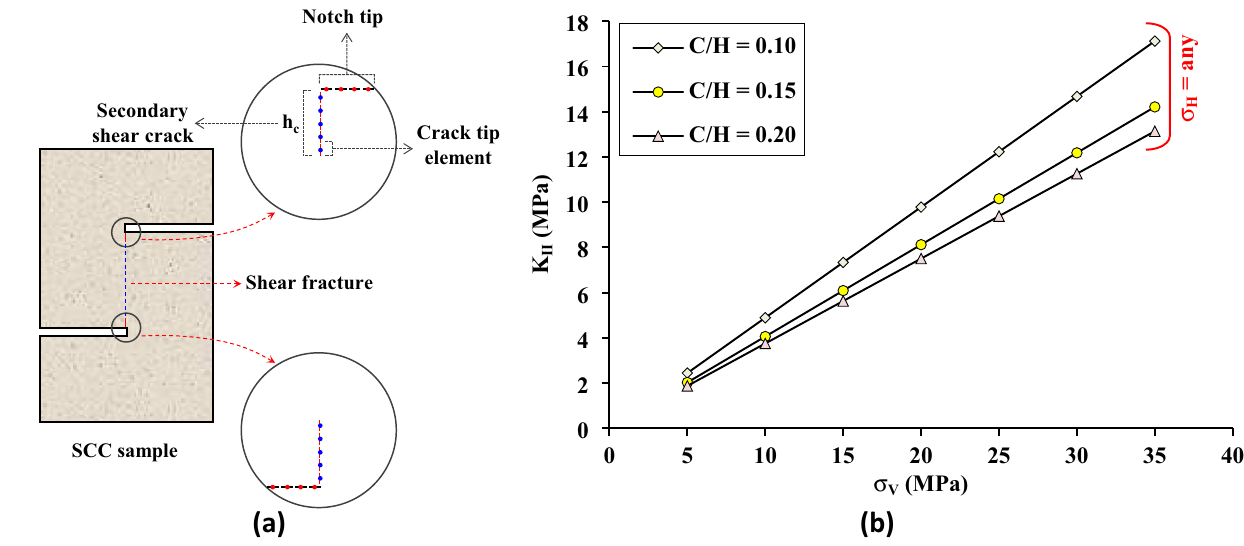
Figure 3. Stress intensity factor in SCC specimens, ( a ) modeling of the secondary shear crack in SCC specimen using DDM, ( b ) mode II stress intensity factor versus σ V and C/H ratio for any value of lateral stress σ H